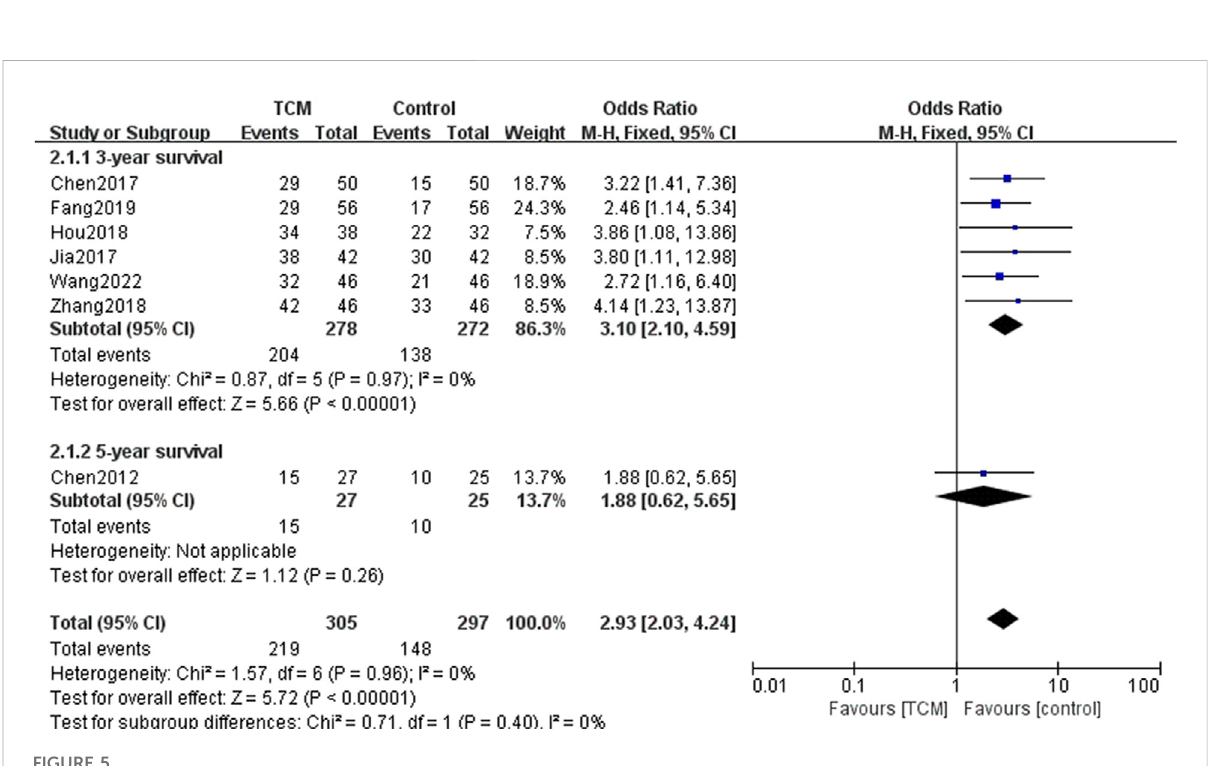
FIGURE 5 Forest plots and subgroup analysis for comparison of OS between TCM group and control